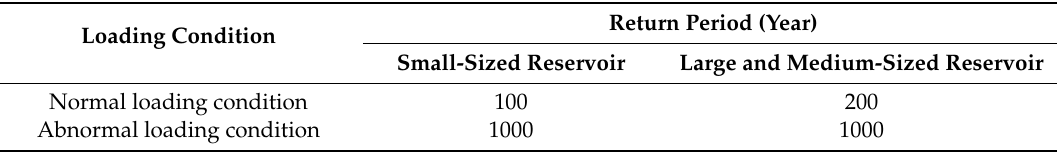
Table 10. Flood control standard for reservoir engineering in Germany.